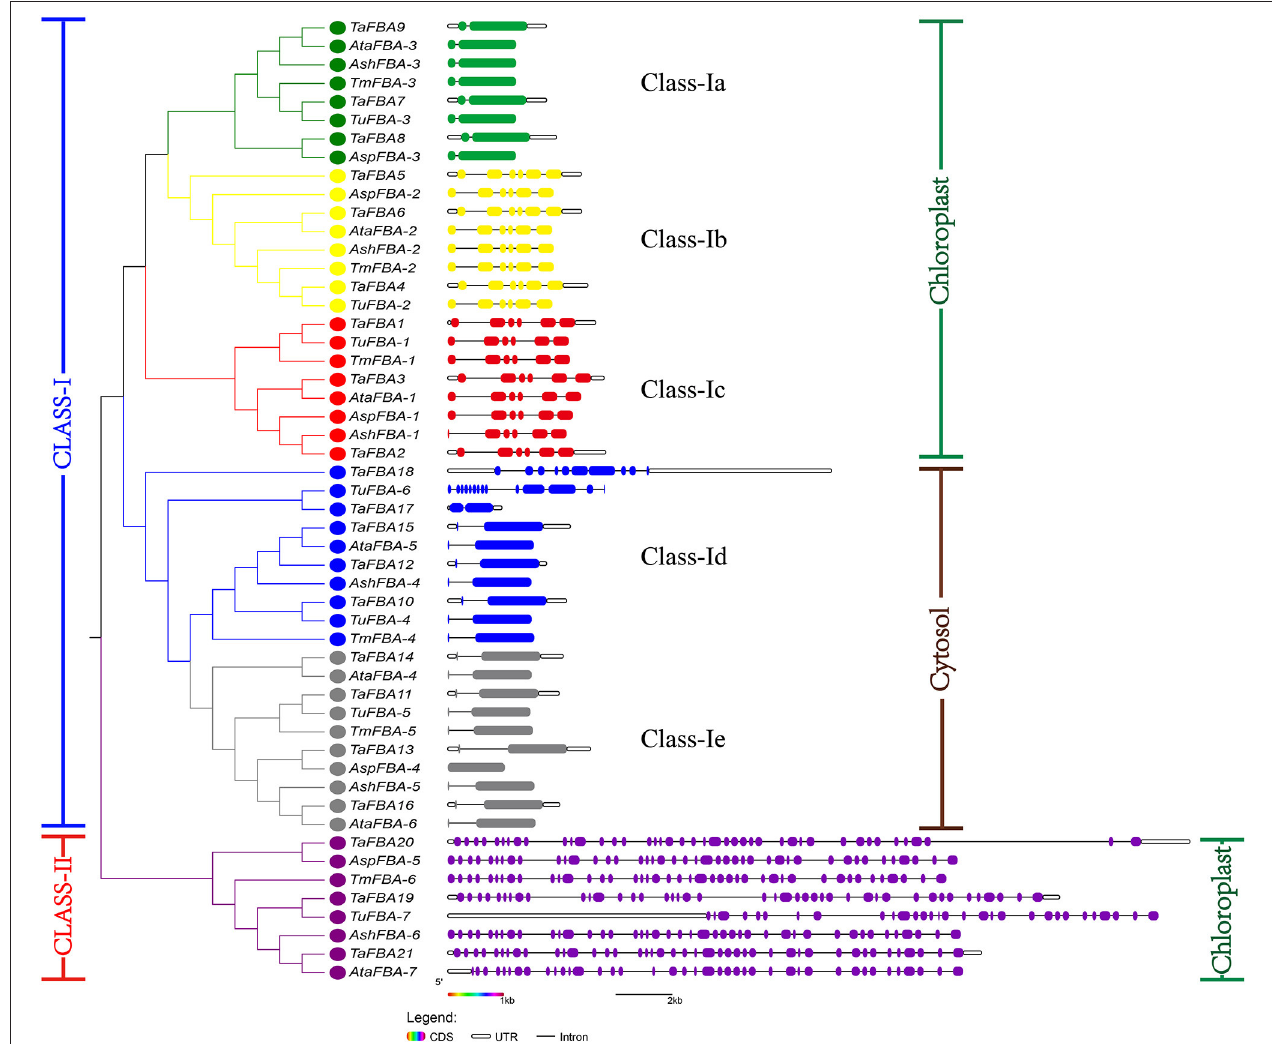
FIGURE 2 | Exon–intron organization and the phylogenetic analysis of the FBA gene families in wheat and wheat relatives. Gene structures of FBA s analysed by GSDS. Exons are shown as Double-sided wedges, and different colours indicate different FBA gene groups. Introns are shown as thin lines. Untranslated regions (UTRs) are shown as blank boxes. The exon and intron sizes can be estimated using the scale at the bottom. TaFBA , TmFBA , TuFBA , AspFBA , AshFBA , AtaFBA indicated the FBA genes from T. Aestivum , T. monococcum , T. urartu , A. speltoides , A. Sharonensis , A. tauschii respectively. The unrooted tree was generated using MUSCLE in